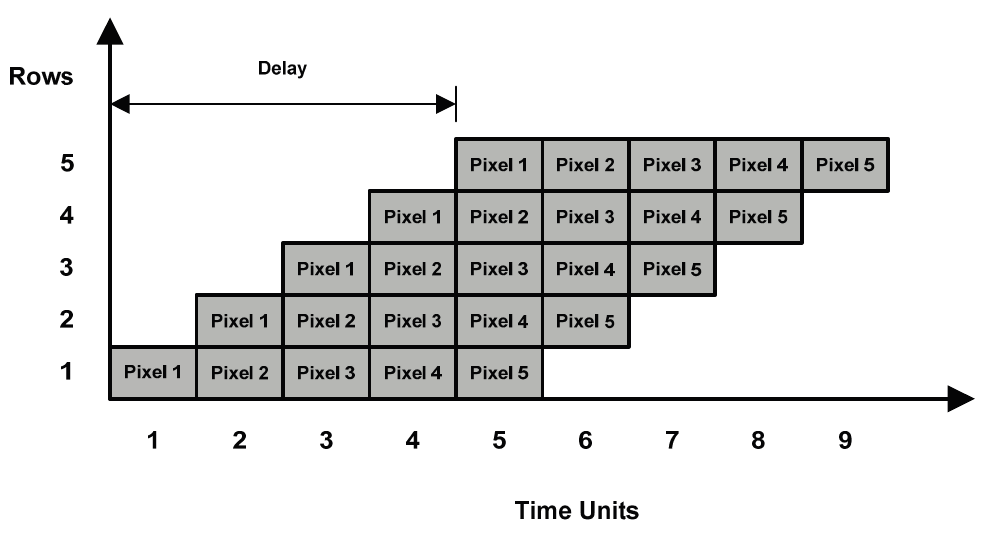
Figure 4. Time delay between computation of integral image values for different